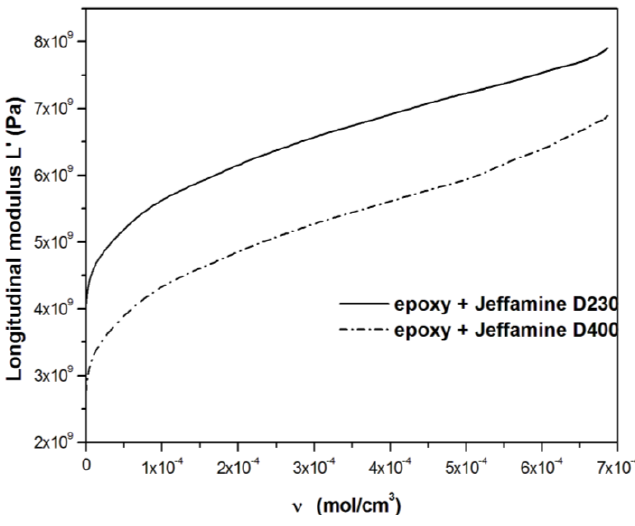
Figure 8. Correlation between L ' and the concentration of active network chains ν after the gel point, during the cure of epoxy resin DGEBA at 85 °C with Jeffamine D230 and